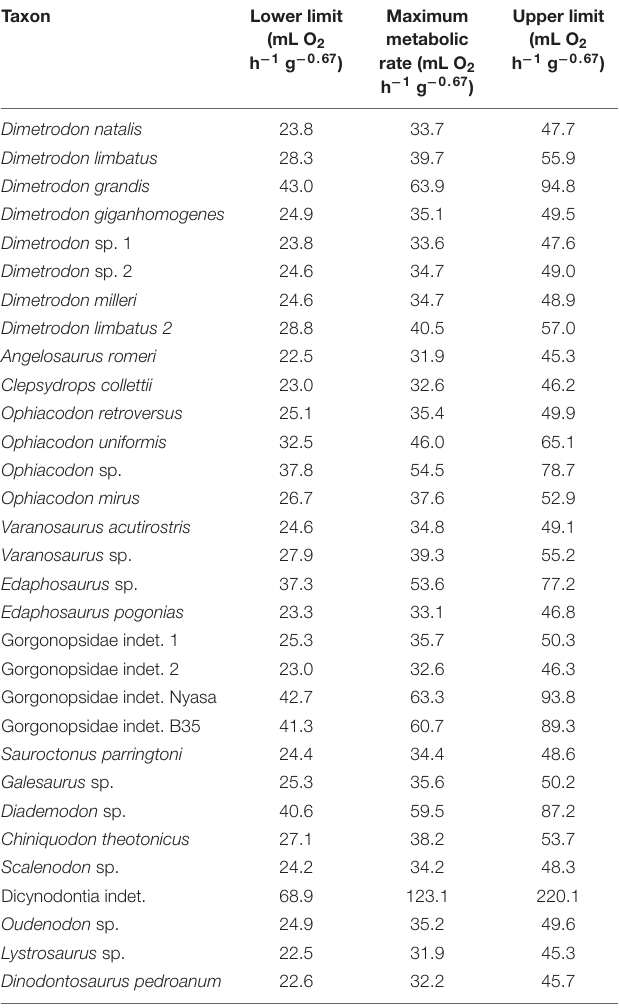
TABLE 1 | Predicted maximum metabolic rates calculated through phylogenetic eigenvector maps with Q i as co-predictor. Taxon Lower limit (mL O